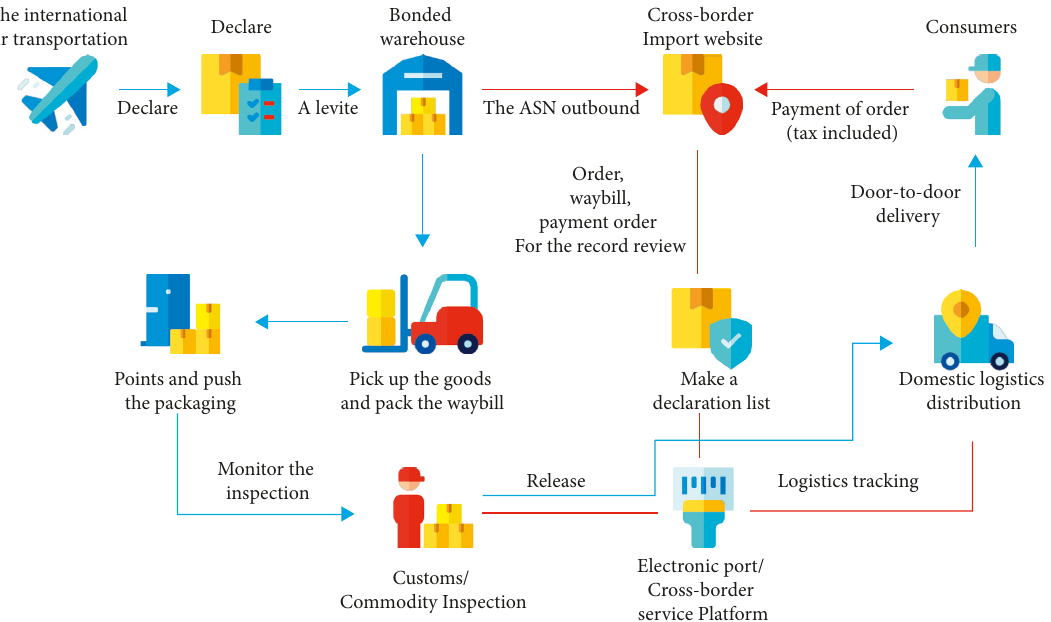
Figure 1: Modeling and identification